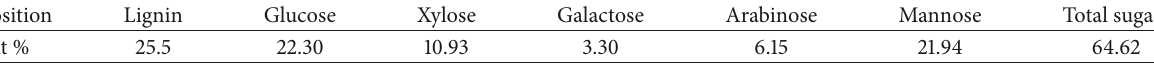
Table 1: Composition of ginkgo LCC-based biocarrier.